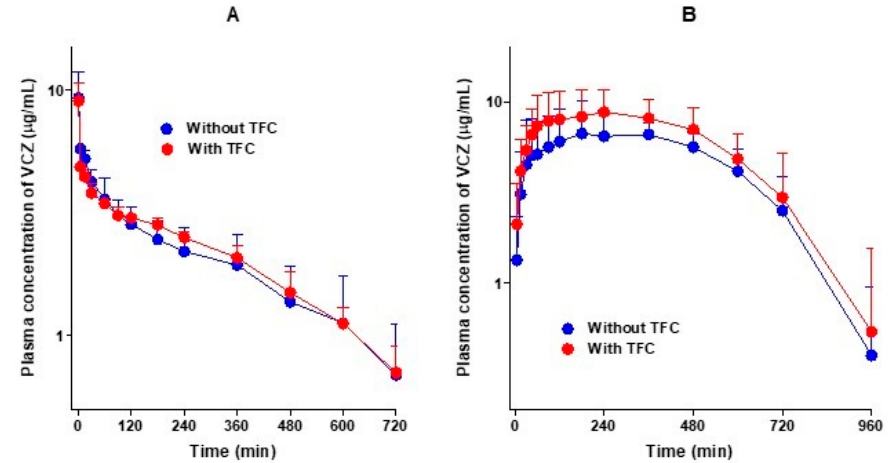
Figure 3. Average arterial plasma concentration–time curves of voriconazole (VCZ) after the administration of voriconazole intravenously ( A ) without ( n = 6) and with ( n = 5) tofacitinib (TFC, 10 mg/kg for each drug) and orally ( B ) without ( n = 6) and with ( n = 7) tofacitinib (20 mg/kg for each drug) to Sprague–Dawley rats. Bars represent standard deviations. Table 2. Pharmacokinetic parameters of voriconazole after intravenous (10 mg/kg) and oral (20 mg/kg) administration of voriconazole without and with tofacitinib (TFC, 10 and 20 mg/kg for intravenous and oral administration, respectively) to Sprague–Dawley rats. Values are means ± standard deviation (SD).